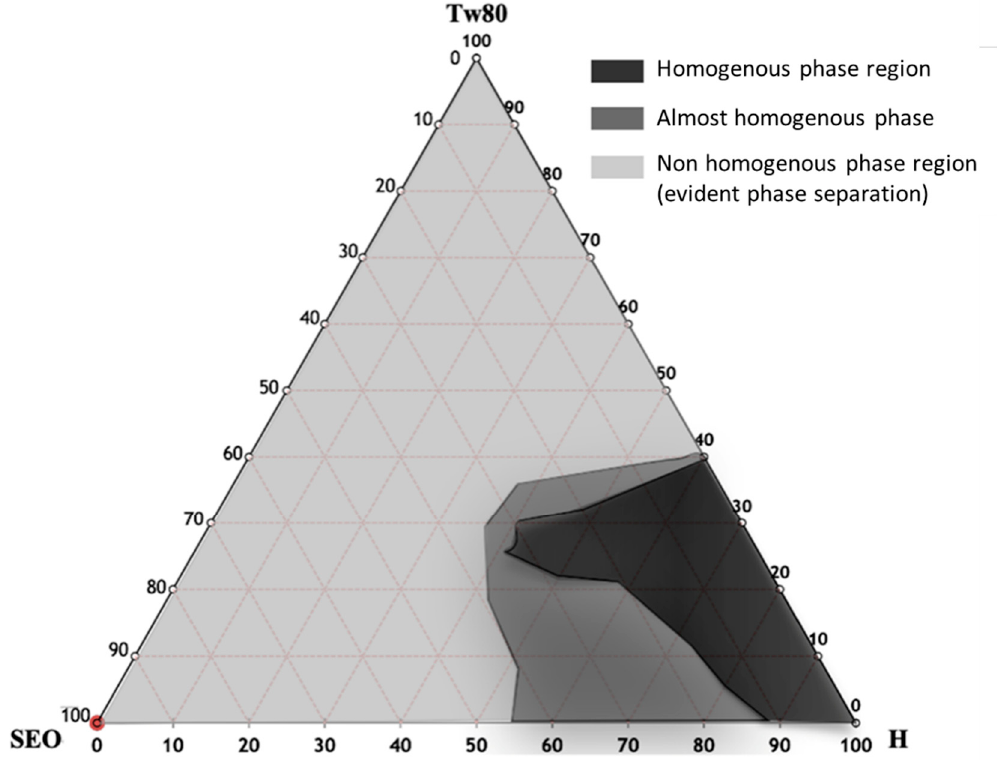
Figure 2. Ternary phase diagrams between SEO, Tween-80, and HEPES buffer (black colored region indicates the self- emulsification region). The resulting phases observed were the homogenous phase (black region), and two-phase region (dark and light grey). Table 2. Hydrodynamic diameter, ζ -potential, and polydispersity index (PDI) values of sample 21 pre- and post-sonication. Sample 21